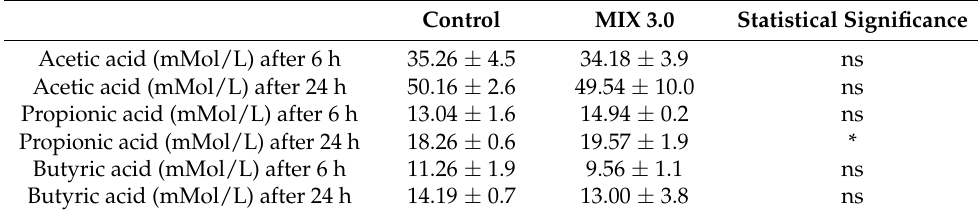
ns: not significant. *: p <